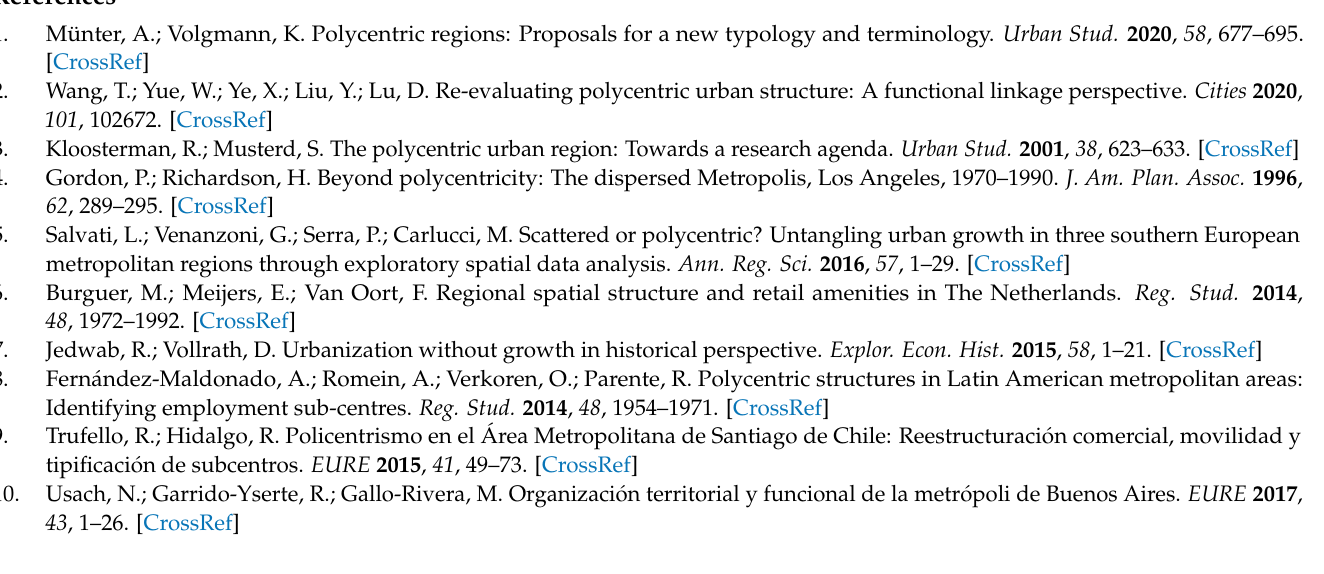
Figure A3. Changes in the accessibility indicator according to the friction parameter: ( a ) friction parameter equal to 0.5, ( b ) friction parameter equal to 2. Source: Based on information from the EEEBR (2017).